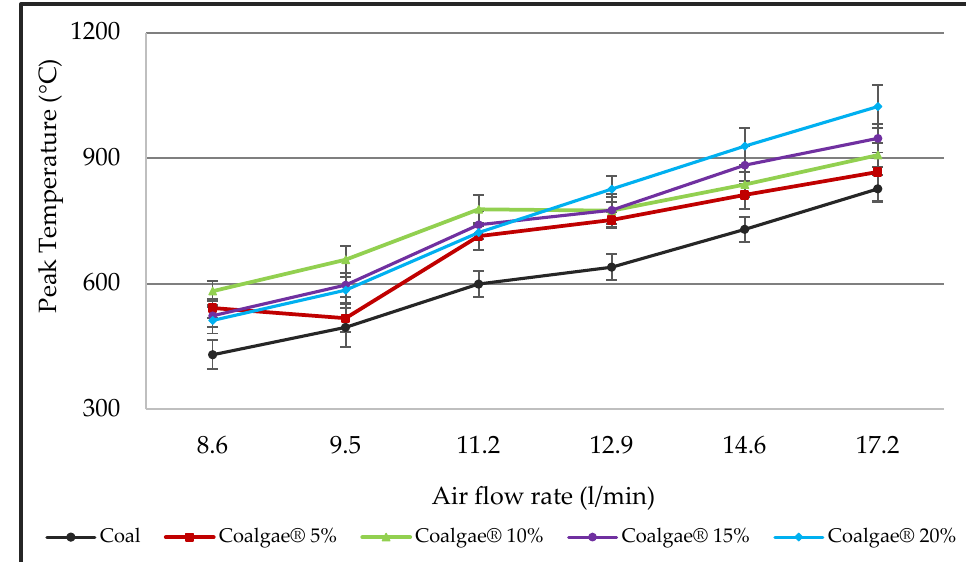
Figure 4. Effect of air flow rate on coal and Coalgae ® blends peak temperature.